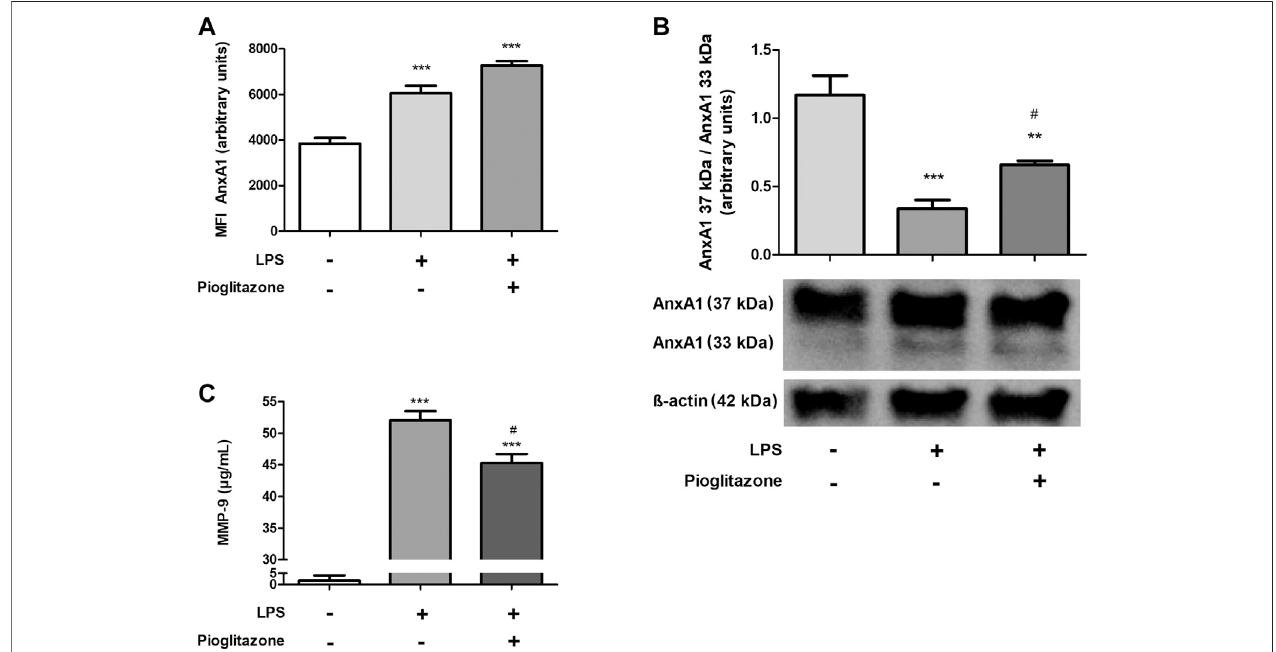
FIGURE 7 | Expression and cleaving of AnxA1 in RAW 264.7 macrophages. Non-transfected (wild-type) RAW 264.7 cells were plated and treated with 10 µM pioglitazone for 1 h followed by 1 μ g/ml LPS for 24 h. Cells were harvested and AnxA1 expression via fl ow cytometry was assessed on part of them (A) ; protein lysates were prepared from the remaining cells and AnxA1 cleaving was assessed via Western Blotting (B) . Culture supernatants were collected and MMP-9 secretion was assessedviaELISA (C) .*,*** p < 0.05,0.001incomparisontothecontrolgroup; # p < 0.05incomparisontotheLPS-treatedgroup.Datawerestatisticallyanalyzed using One-Way ANOVA followed by Tukey ’ s post-test ( n (cid:2) 5). Results are expressed as mean ± SE.